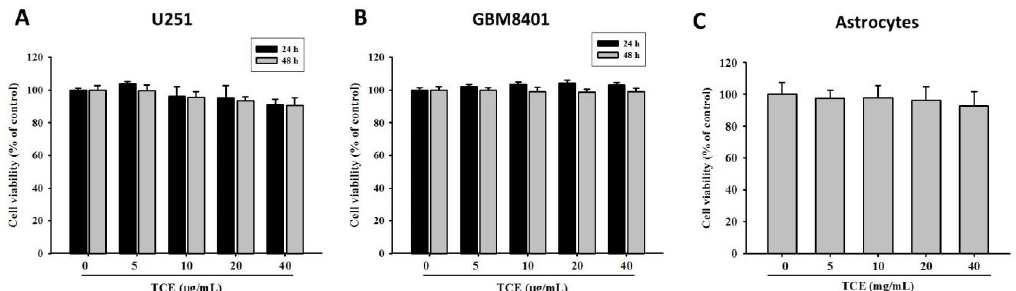
Figure 1. Effects of T. catappa L. extract (TCE) on cell viability. U251 ( A ) and GBM8401 ( B ) cells were treated with different concentrations (0, 5, 10, 20 and 40 μg/mL) of TCE for 24 and 48 h before being subjected to an MTT assay for cell viability. ( C ) Immortalized human astrocyte cells were treated with TCE for 24 h before being subjected to an MTT assay for cell viability. The values shown represent the means ± SD of at least three independent experiments.